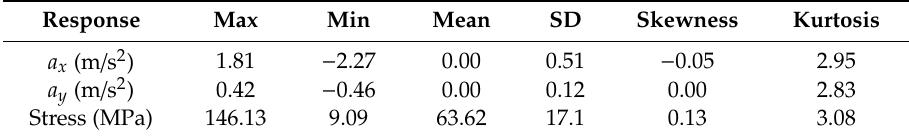
Table 9. Statistics of horizontal and vertical accelerations ( a x , a y ) and tower base stress of a VAWT in